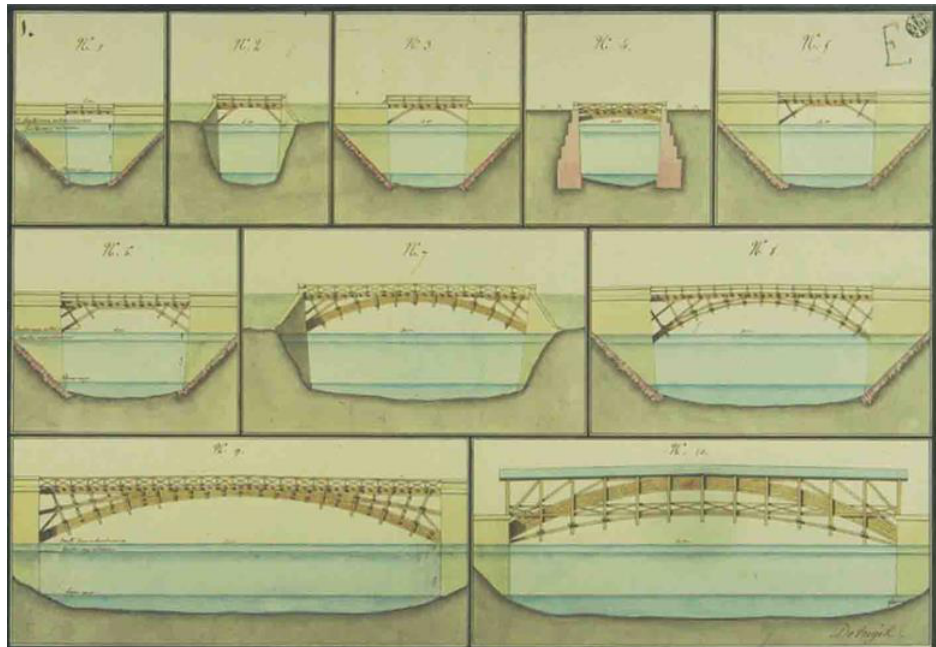
Figure 1. Influence of boundary conditions on the choice of a bridge structural system. “Concours de architecture presso l’École des Ponts et Chaussées”, 1818. Student: Marie Fortunè de Vergés [6] (1. Simple girder; 2 and 3. girder supported by compressed struts; 4. girder reinforced by an additional. beam; 5 and 6 girder supported by compressed and branched struts; 7 and 8. girder supported by a multilayer arch connected through orthogonal wood elements; 9 and 10. More complex schemes).